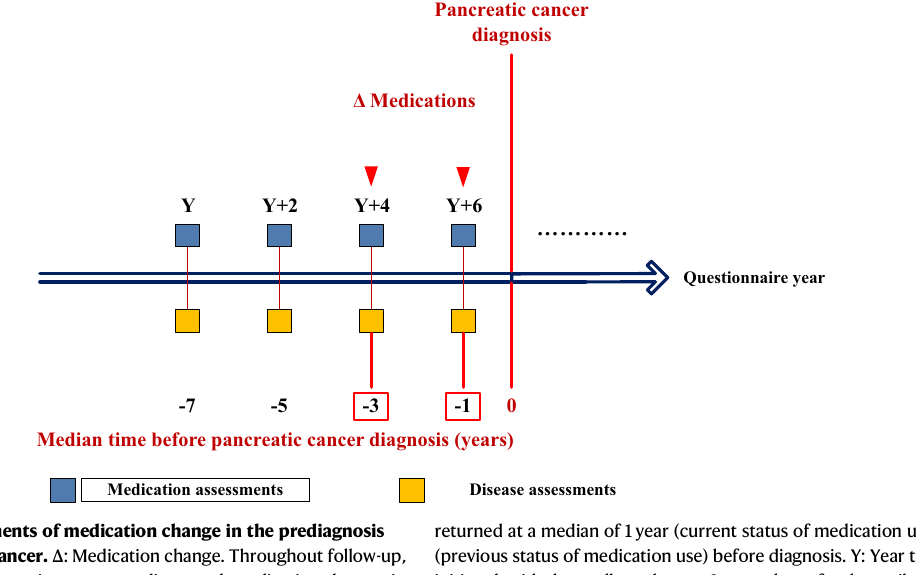
returned at a median of 1year (current status of medication use) and 3years (previous status of medication use) before diagnosis. Y: Year the cohort study was initiated, with data collected every 2years thereafter by mailed